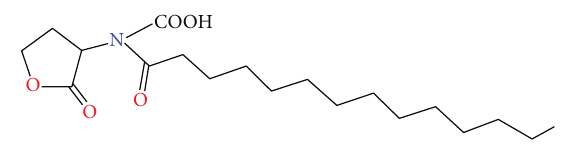
Figure 2: Chemical structure of N-carboxyl-C14-HSL: a putative AHL produced by Methanosaeta harundinacea . The carboxylation modification has only been observed in